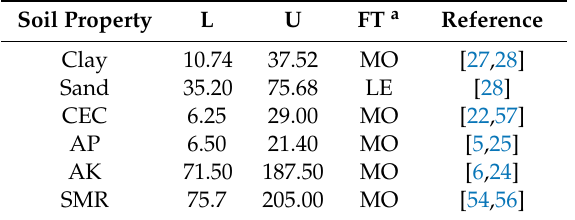
Table 1. Standard scoring functions (SSF) and soil